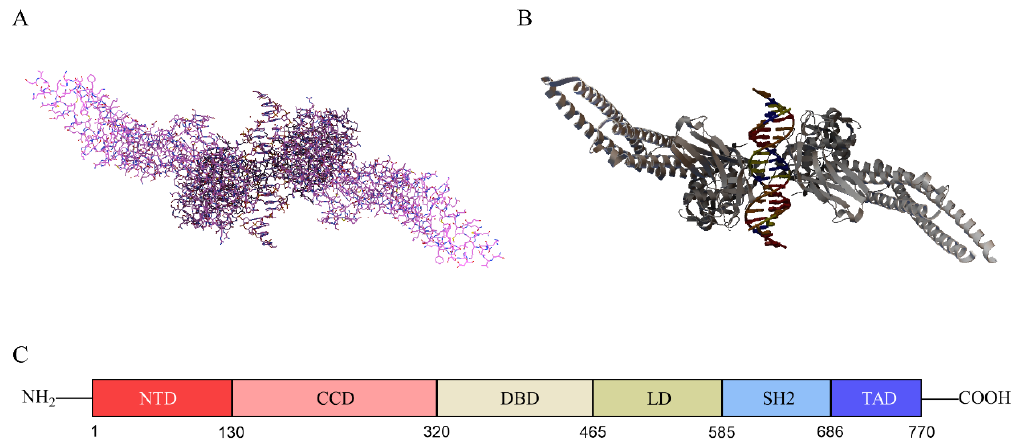
Figure 1. The three-dimensional structure and linear structure of STAT3. ( A ) The protein primary structure of STAT3; ( B ) the protein secondary structure of STAT3; ( C ) the linear structure of STAT3, including six structural domains, N-terminal domain (NTD), coiled-coil domain (CCD), DNA-binding domain (DBD), linking domain (LD), SH2 domain and transcriptional activation domain (TAD). STAT3 structure was retrieved from PDB database (PDB ID: 6QHD), then visualized with PyMol software.